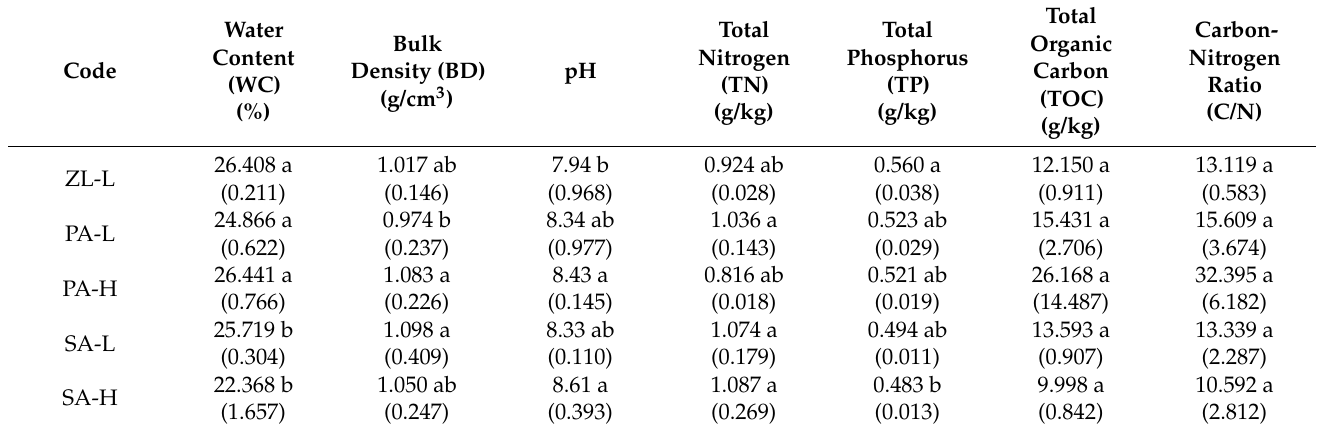
Table 3. Physicochemical properties of the soil at different